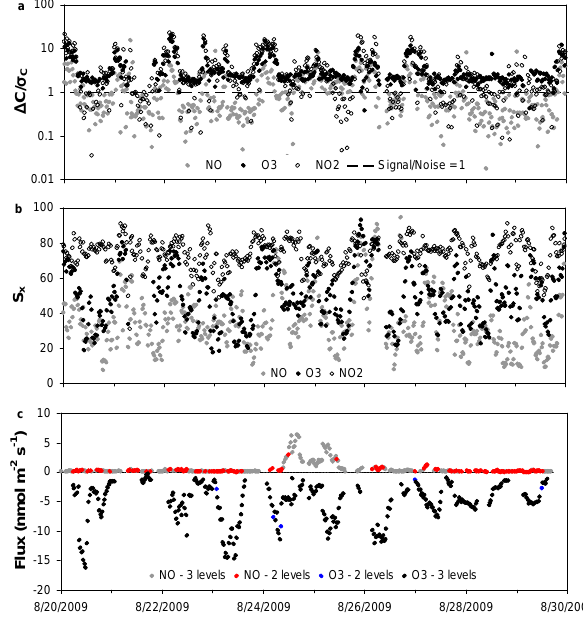
Fig. 4. Time series of (a) the “gradient signal to noise ratio” ( 1C / σ C ) and (b) the stationarity index ( S x ) for NO (grey symbols) O 3 (black symbols) and NO 2 (open symbols). The dotted line in panel (b) corresponds to a signal to 1C / σ C =1. (c) Time series of the fluxes determined by the AGM (without chemical corrections), satisfying both the stationarity test and the Student t-test. The flux was calculated either from 3 heights (grey symbols for NO; black symbols for O 3 ) or 2 heights (red symbols for NO; blue symbols for O 3 ) based on the t-tests (see text for details). Note that NO 2 fluxes are not represented because they failed both the t-test and stationarity